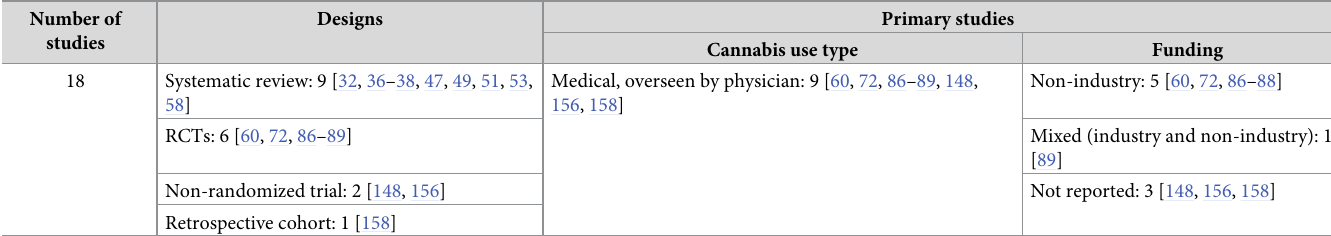
Table 5. Characteristics of studies evaluating the impacts of cannabis use in individuals with Alzheimer’s disease or